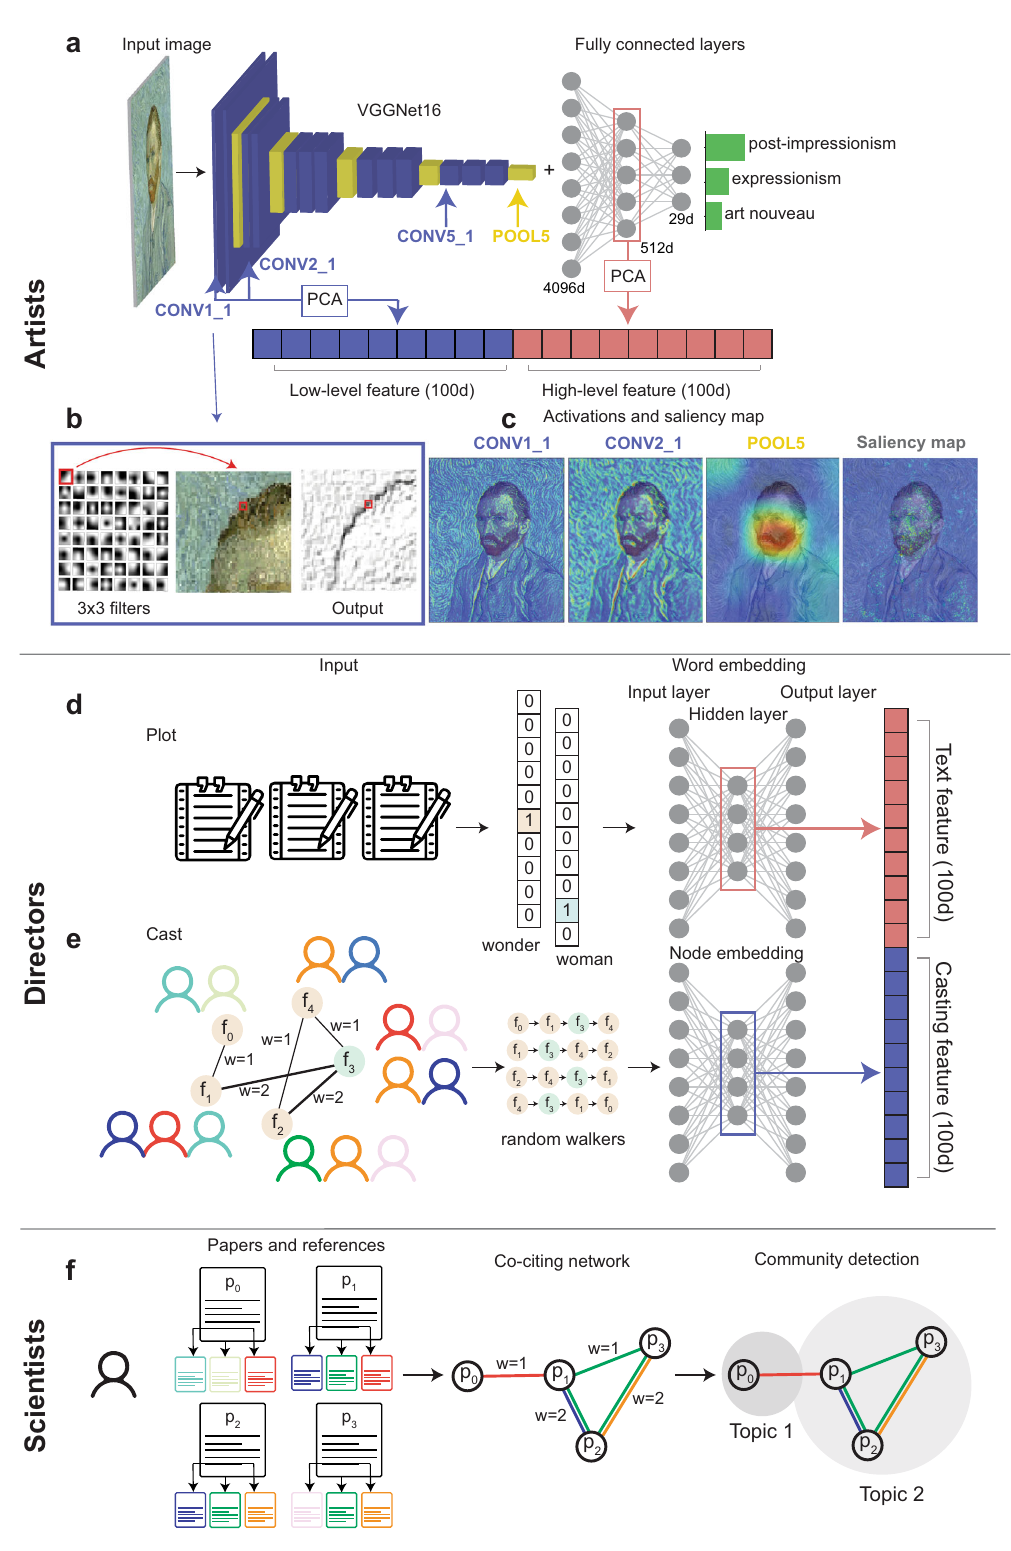
systematically elevated before a hot streak begins, but drops precipitously below expectation during the hot streak. We further compare directly the entropy distribution P ð H Þ before and after the hot streak begins, fi nding that, across all three domains, H during a hot streak is systematically smaller than before (Fig. 3m – o, Kolmogorov – Smirnov (KS) test, p value <0.001); this